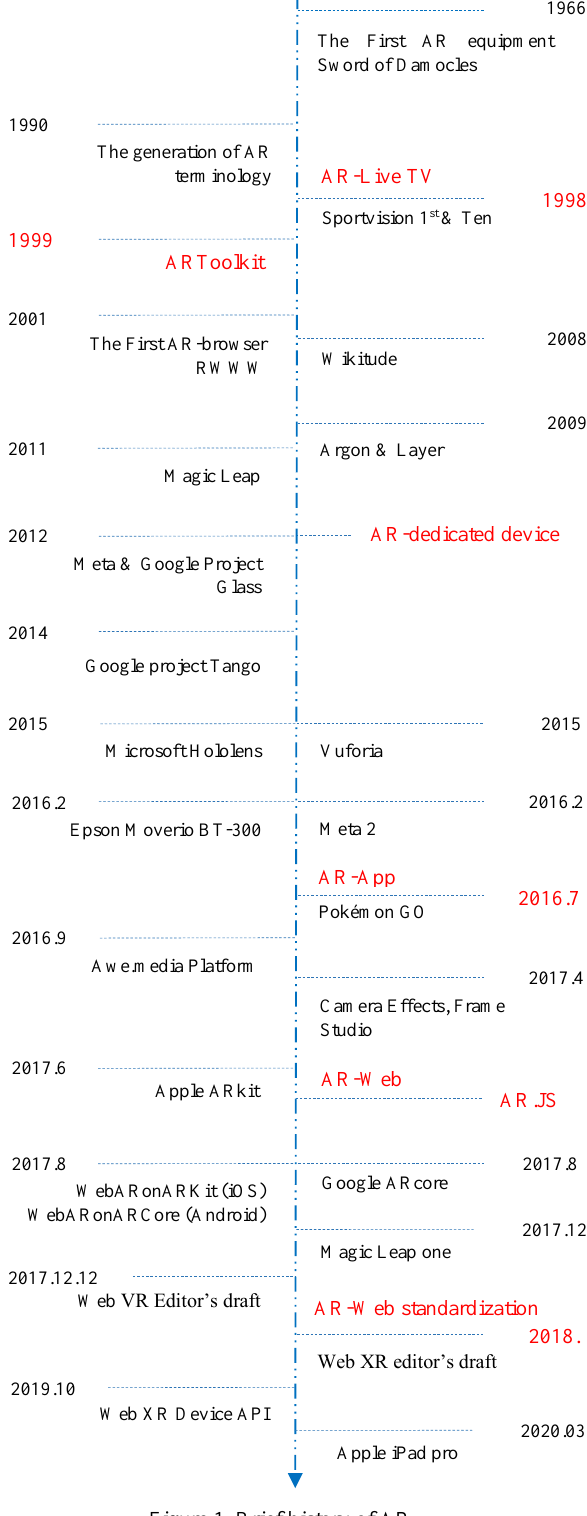
Figure 1. Brief history of